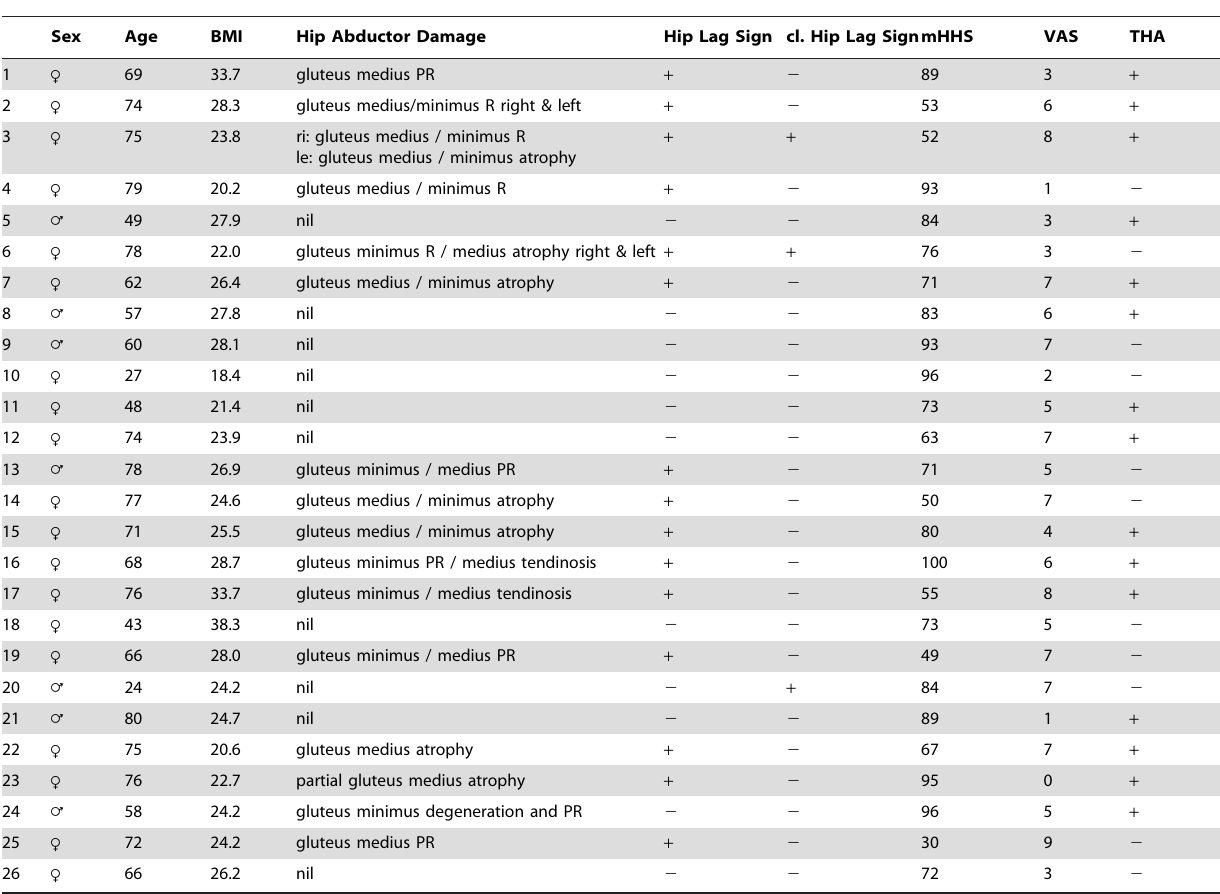
Table 1. Shown are the patients’ characteristics of all included